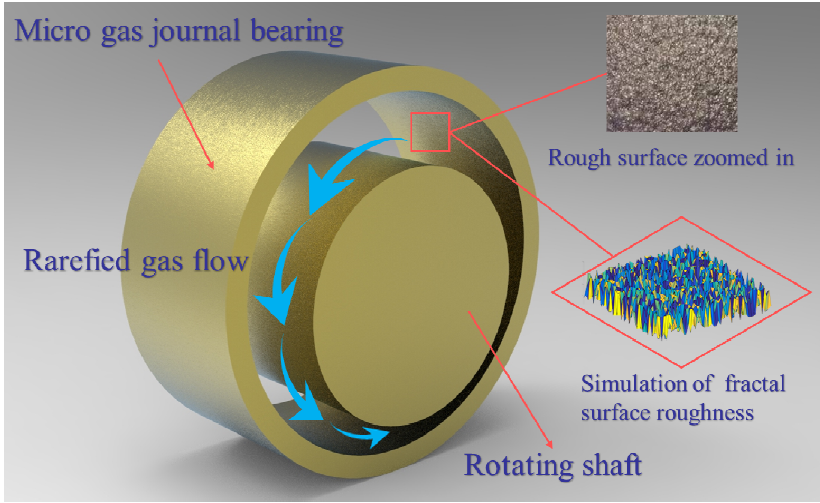
Figure 2. Schematic of a rough-surface gas-lubricated journal microbearings.